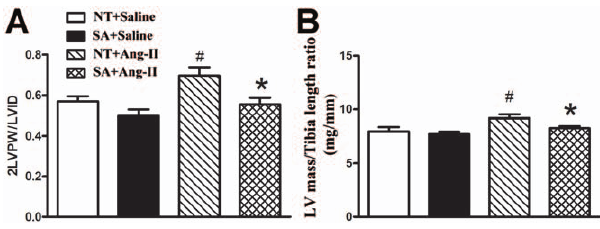
Figure 1. ACE2 over expression decreases Ang II-induced left ventricle cardiac hypotrophy. 2 weeks after Ang II or saline infusion, echocardiography were performed on 3 different cardiac cycles, the values averaged and used to calculate 2PW/LVD; then, mice left ventricle were collected and tibia length were measured for calculation of LV mass/Tibia ratio. ACE2 over expression significantly reduced the increase of 2PW/LVD ( A ) and LV mass/Tibia ratio ( B ) in SA compare to NT mice following Ang II infusion (P , 0.05). N=8/group. Statistical significance: * P , 0.05 vs. NT with the same treatment; # P , 0.05 vs. saline with the same genotype.